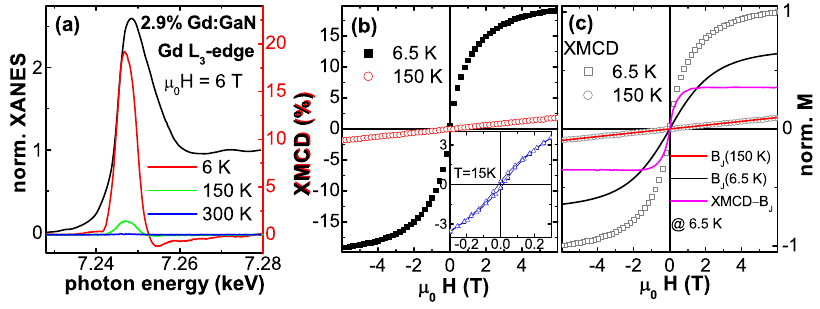
-edge of the 2.9% 3 (see J